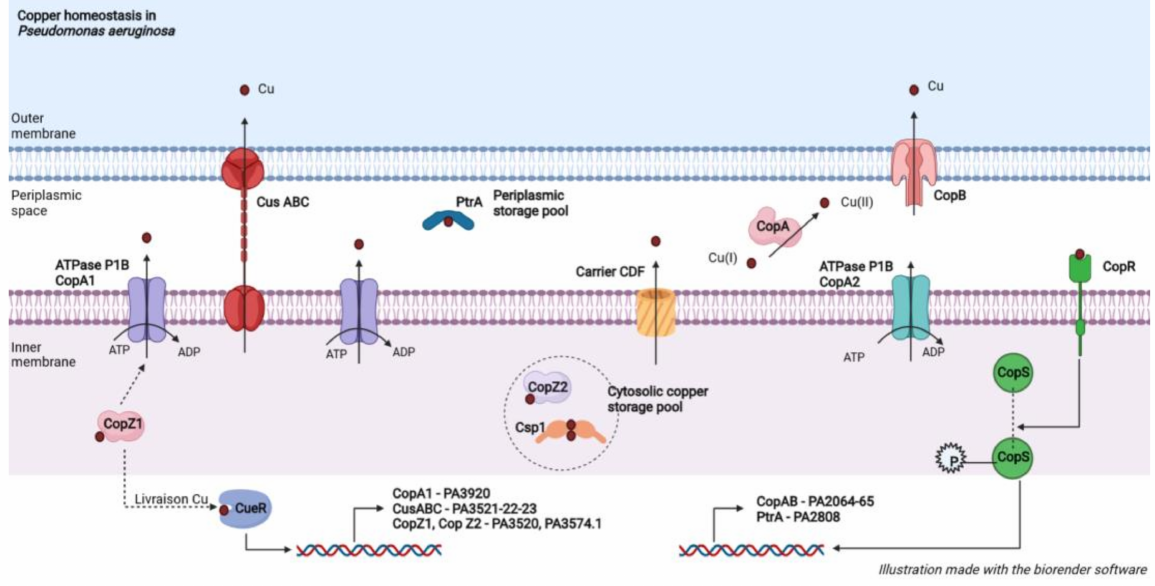
Figure 1. Proteins involved in the copper homeostasis of P. aeruginosa . The proteins are depicted in a schematic